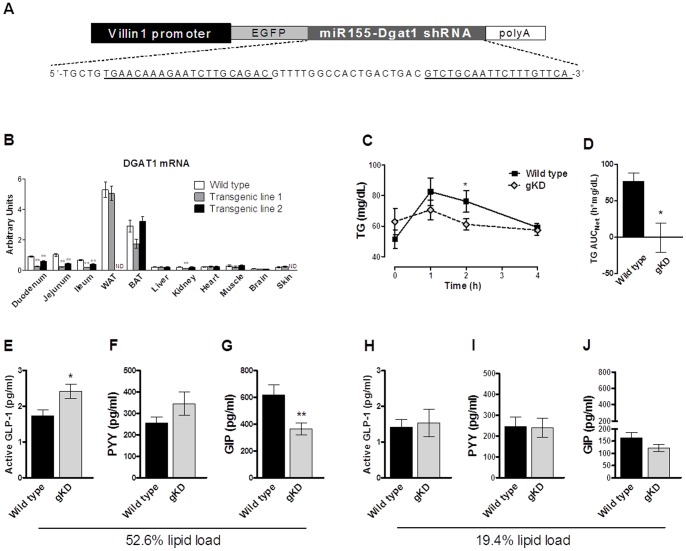
Gut-selective DGAT1 knockdown and its effects on TG and gut hormones.(A) Design of the transgenic construct used to generate DGAT1 gKD mice. A transgenic vector was constructed that contains a 12.4 kb Villin1 promoter, a sequence encoding EGFP, followed by miR155-embedded Dgat1 shRNA and a poly-A tail. Sequence of the miR155-embedded Dgat1 shRNA is shown, with the sequences homologous to Dgat1 underlined. (B) DGAT1 mRNA expression in selected tissues from two DGAT1-shRNA transgenic lines and wild type control littermates. N = 3–5. Data are normalized against Rplp0 mRNA. ND: not determined. (C, D) 4-month-old female gKD mice and wild type littermates were fasted overnight, then p.o. dosed with corn oil at 10 ml/kg. Plasma TG was measured at 0, 1, 2, and 4 h after oil challenge, and net area-under-the-curve (AUC) compared to time 0 was calculated. Overnight fasted gKD mice and wild type littermates were p.o. dosed with a mixed meal containing (E–G) corn oil:Ensure-plus = 1∶1 (52.6% lipid load, 4.81 kcal/ml) or (H–J) corn oil:Ensure-plus = 3∶17 (19.4% lipid load) at 10 ml/kg. Plasma levels of active GLP-1, PYY, and GIP were measured at 2 h after meal challenge. N = 10–14. *P<0.05, **P<0.01 vs. wild type.